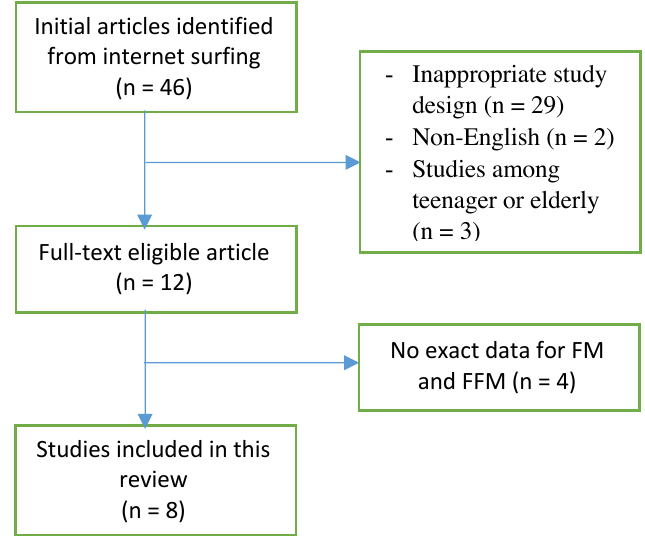
Figure 1 . Flow of the study selection